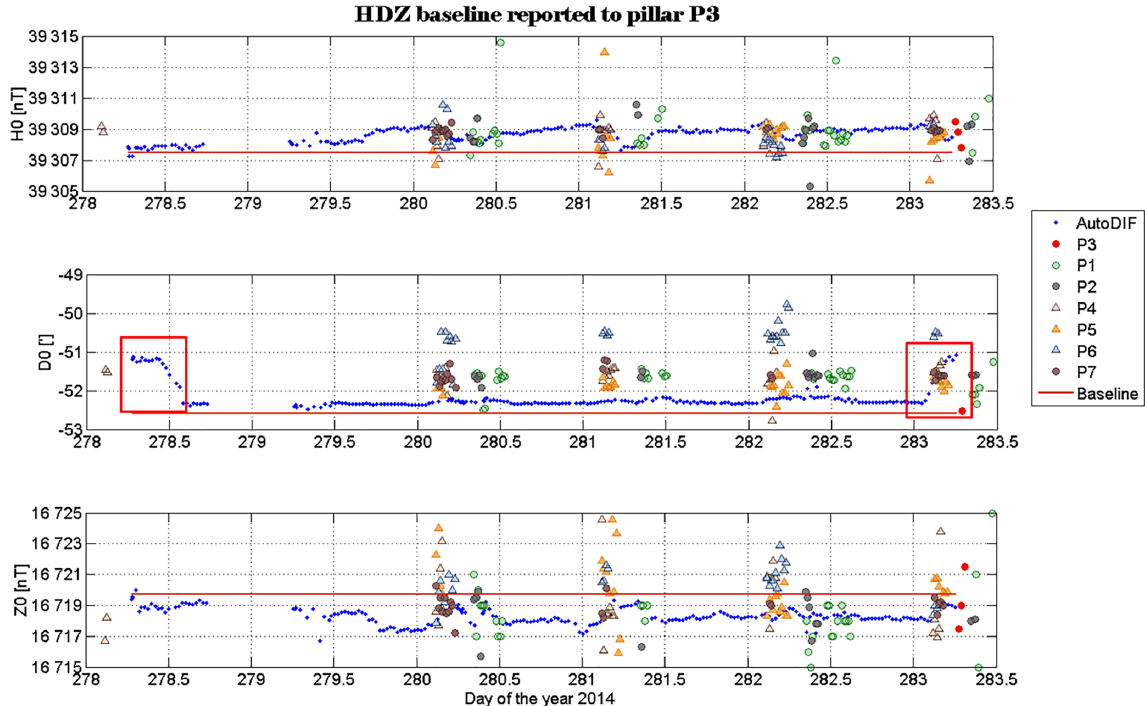
Figure 8. AutoDIF on its pillar during the 16th IAGA Workshop in